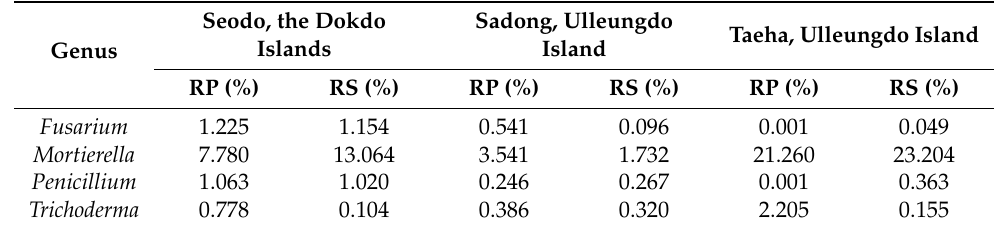
Table 3. Variation of the major fungal genera.